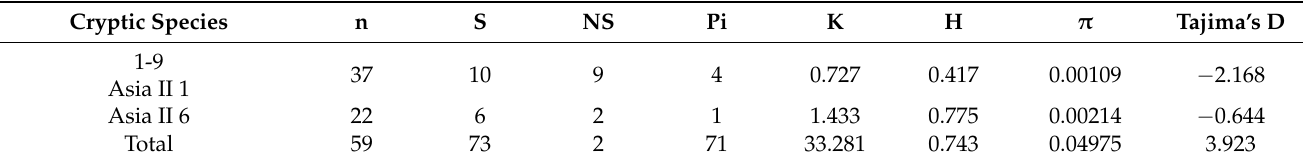
Table 2. Distribution and frequency of cryptic species found in Lao PDR. n = number of sequences; S = number of polymorphic sites; NS = Singleton’s number; Pi = parsimony-informative sites; k = average number of nucleotide differences; h = haplotypic diversity; π = nucleotide diversity; Tajima’s D = neutrality